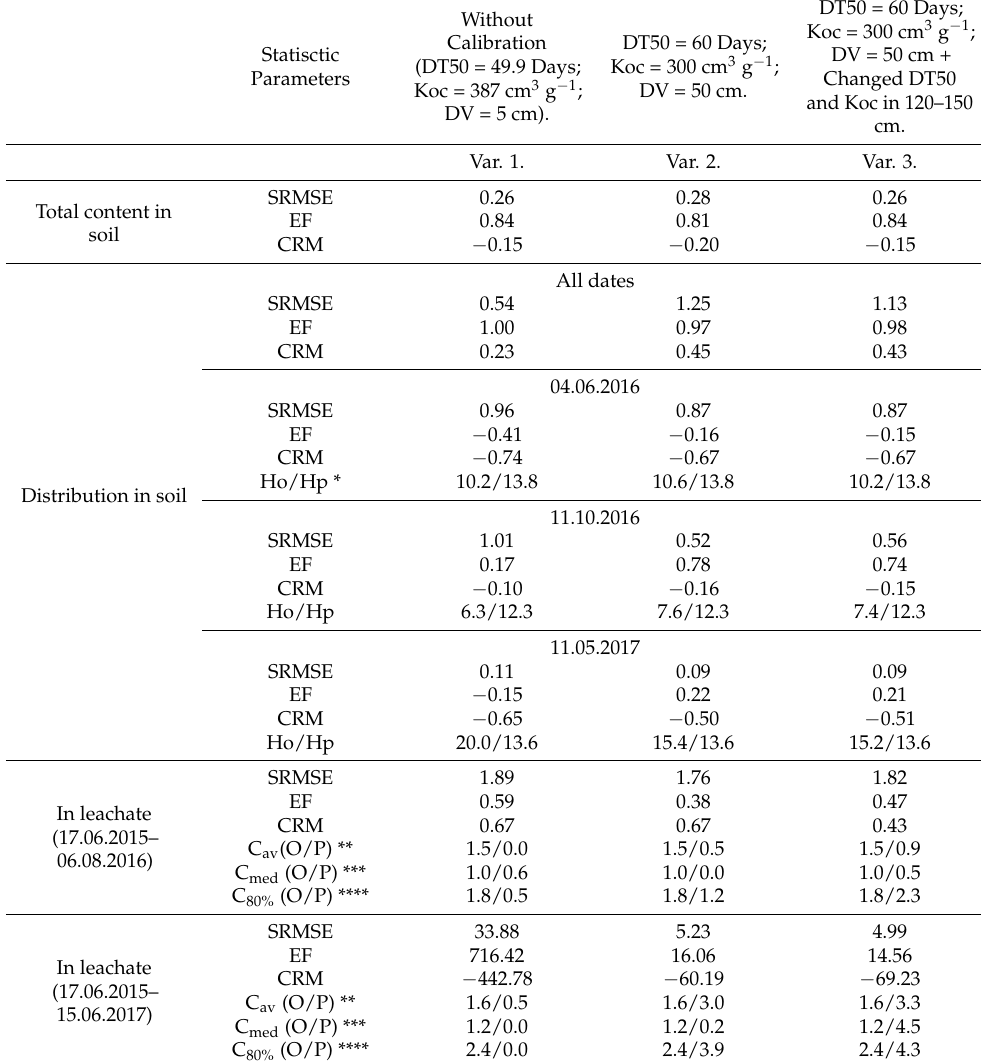
Table 9. Goodness-of-fit criteria of accordance between observed and predicted cyantraniliprole concentration in the soil profile and in the